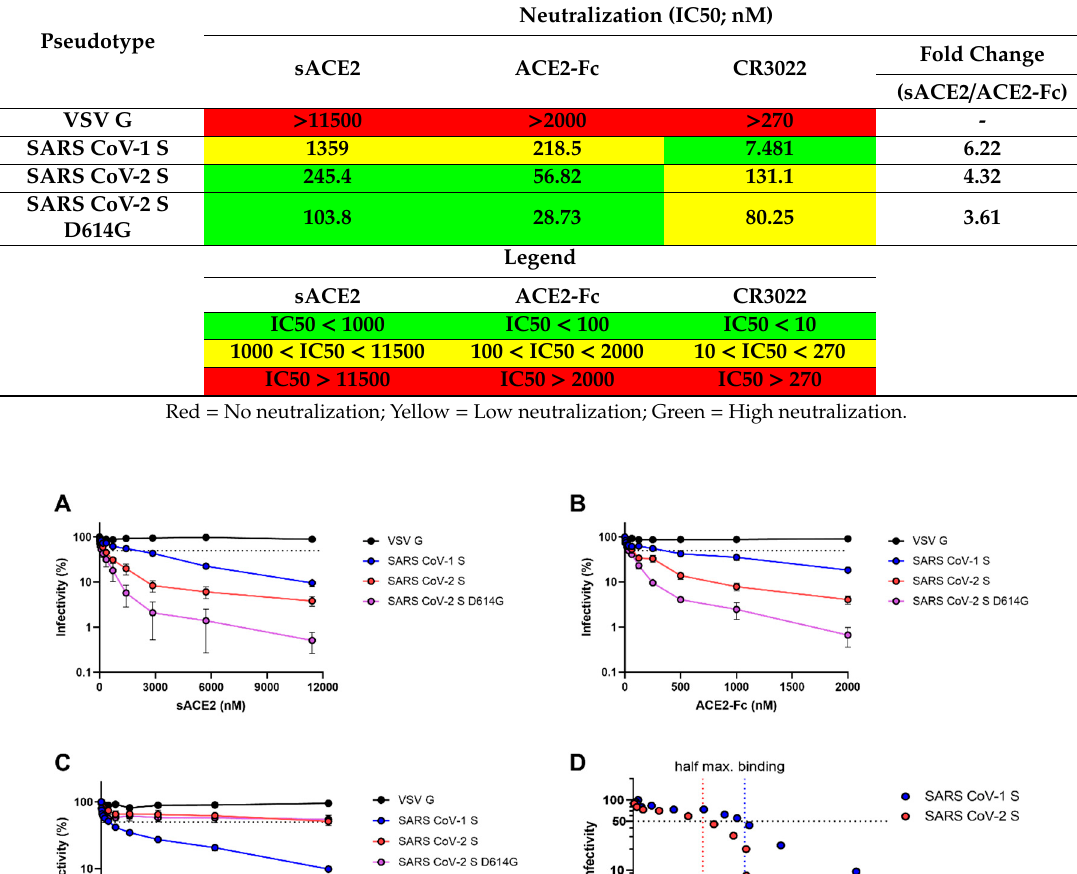
Table 1. Neutralization half-maximal inhibitory concentrations (IC 50 ). VSV-G—vesicular stomatitis virus G.